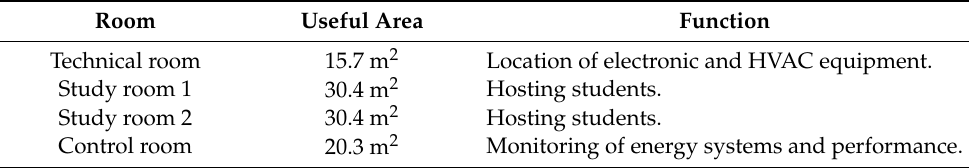
Table 2. Description of the test facility rooms.